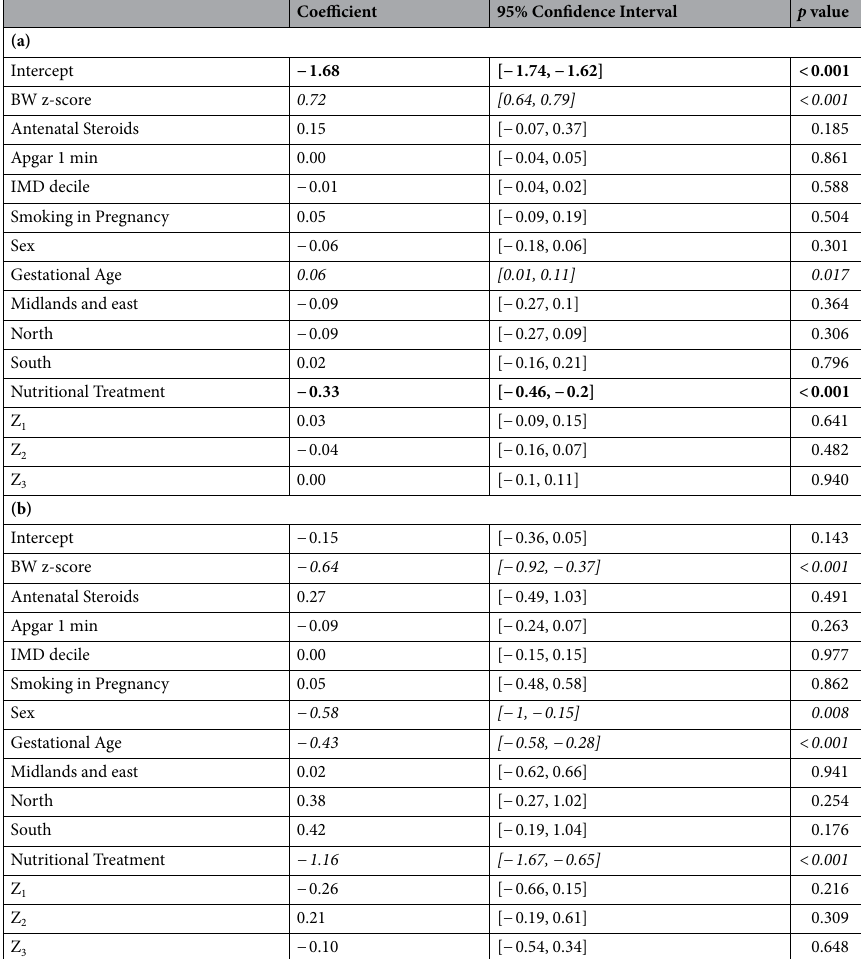
Table 3. Association between nutritional patterns and 2 clinical outcomes. Regression coefficients, 95% confidence intervals and p values are reported for all tested covariates, and the three latent variables (Z 1 , Z 2 and Z 3 ) of the factor model that facilitate deconfounding. We excluded infants with any missing values for the studied variables and used London as the reference category for geographical location. (a) Linear regression on weight z-score at 36 weeks postmenstrual age (W36 z-score), comparing clusters 13 (n = 371) and cluster 16 (n = 339). (b) Logistic regression on BPD, comparing cluster 17 (n = 376) to 18 (n = 283). Coefficients in (a) measure effect on the outcome by a change of one unit in the corresponding covariate. Coefficients in (b) measure change in log-odds ratio of the outcome by a change of one unit in the corresponding covariate. “Nutritional Treatment” = binary covariate encoding inclusion in one cluster versus the other. Significant ( p < 0.05) covariates are highlighted in bold/italic if inducing a negative/positive effect on the outcomevariable when the associated covariate is quantitatively